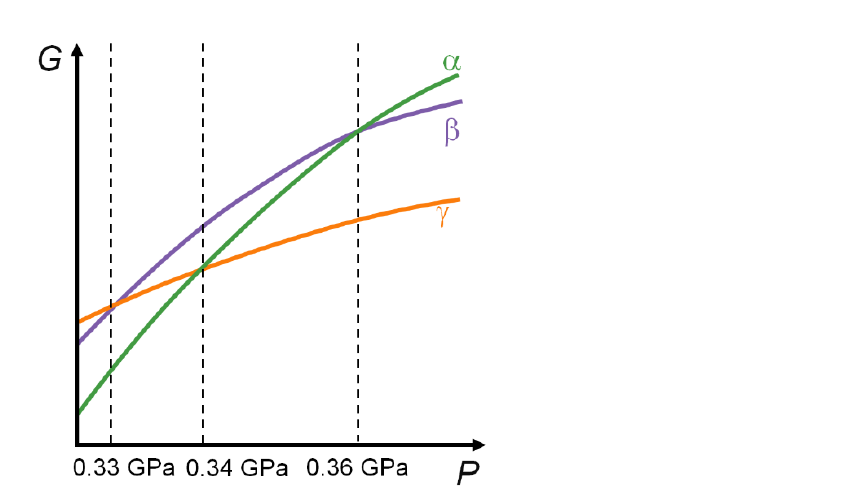
Figure 6. Suggested relations between the free Gibbs energy of phases α , β , and γ as a function of pressure based on a periodic DFT study where only enthalpies were calculated. Table S4 shows the relative phase stability according to calculated enthalpies in different pressure ranges.